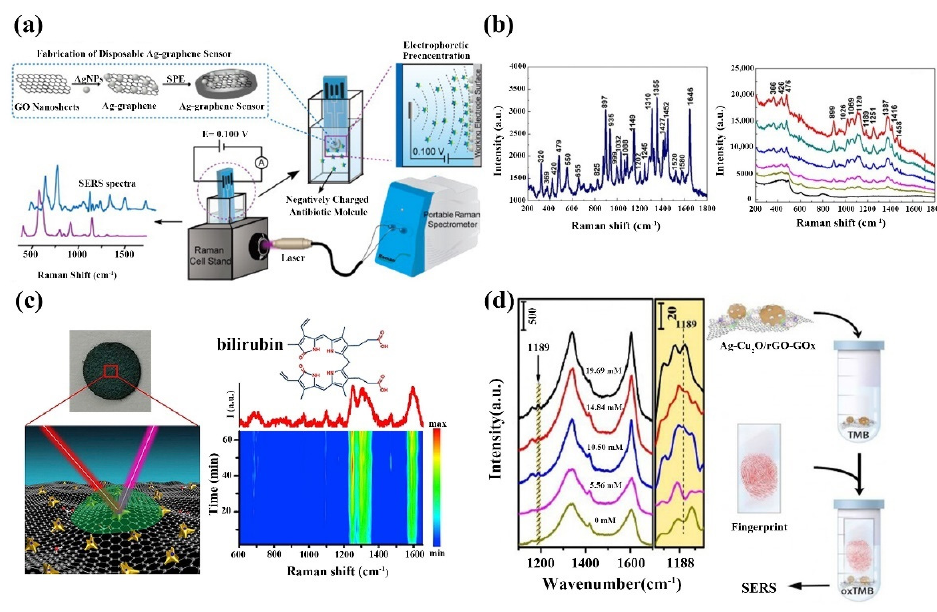
Figure 12. ( a ) Schematic diagram of a disposable ag-graphene sensor for the detection of polar antibiotics in water. Reprinted with permission from Ref. [159]. Copyright 2013, Elsevier. ( b ) Nor- mal Raman spectra of L -theanine ( left ); SERS spectra ( right ) of L -theanine adsorbed on GO/silver nanocomposites at different concentrations (10 − 2 , 10 − 3 , 10 − 4 , 10 − 5 , 10 − 6 , 10 − 7 mol/L from top to bot- tom, respectively). Reprinted with permission from Ref. [160]. Copyright 2017, Elsevier. ( c ) Schematic illustrating the operating principle ( left ) of the developed enPSERS biosensor, molecular structure ( top right ) and the averaged SERS spectrum ( bottom right ) over the measurement period of bilirubin. Reprinted with permission from Ref. [162]. Copyright 2019, Elsevier. ( d ) SERS spectra ( left ) of oxi- dized tetramethylbenzidine (TMB) molecules on the surface of fingerprints of diabetic patients and normal subjects in the presence of Ag-Cu 2 O/rGO substrate and glucose oxidase (Gox). A schematic diagram ( right ) of SERS detection of fingerprints using Ag-Cu 2 O/TGO nanocomposites as SERS substrates. Reprinted with permission from Ref. [164]. Copyright 2017, American Chemical